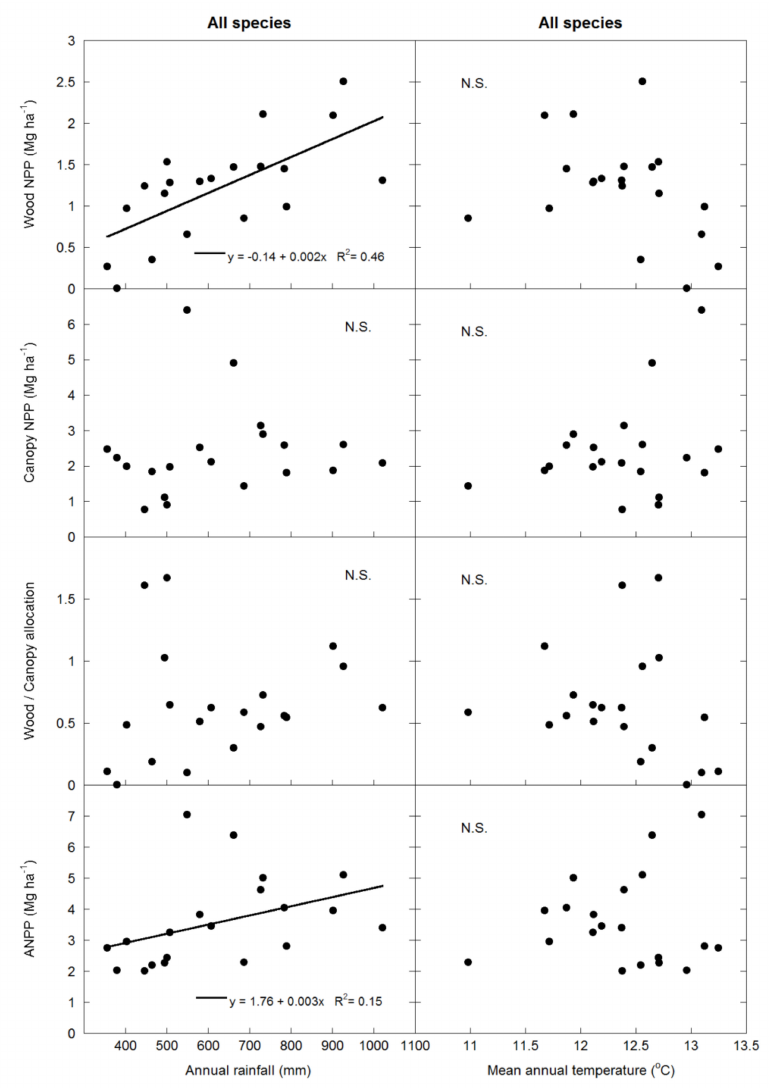
Figure 1. Linear relationships between average net primary productivity (NPP) values (wood NPP, canopy NPP, aboveground net primary productivity (ANPP), and wood / canopy allocation) and meteorological data (annual rainfall and mean annual temperature) of all species analyzed